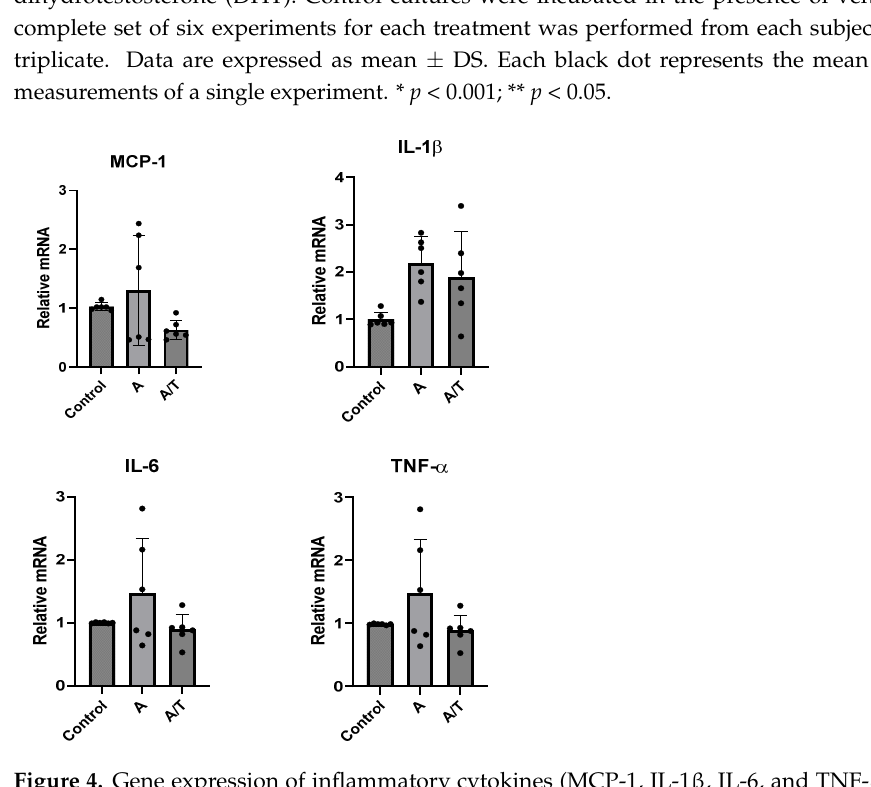
Figure 3. LPS-stimulated expression of inflammatory cytokine genes(MCP-1, IL-1 β , IL-6, TNF- α in human adipocytes in the absence and presence of testosterone (T), 17 β -estradiol (E), and dihy- drotestosterone (DHT). Control cultures were incubated in the presence of vehicle only. A complete set of six experiments for each treatment was performed from each subject and run in triplicate. Data are expressed as mean ± DS. Each black dot represents the mean of triplicate measurements of a single experiment. * p < 0.001; ** p < 0.05.